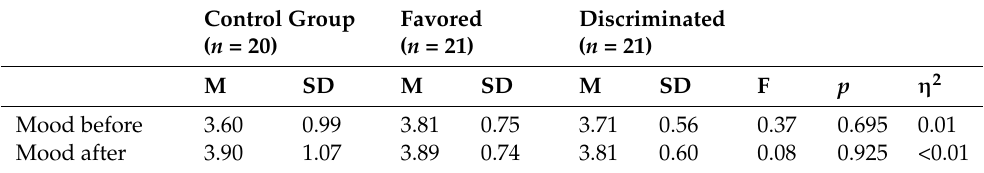
Table 2. Differences in the participants’ mood before and after the team